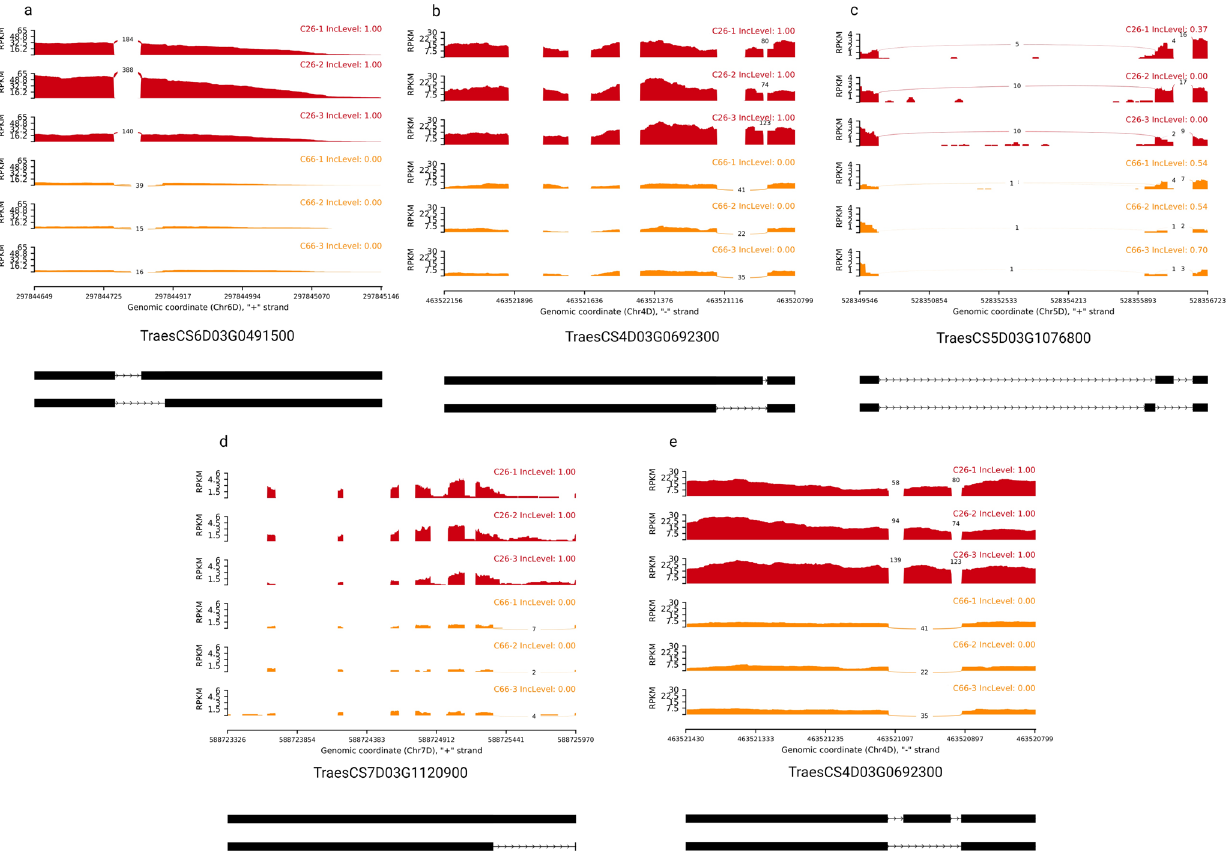
Fig. 9 Sashimi plots representing examples of the fi ve types of alternative splicing events in the shoot tissue of Ae. tauschii C26 line (diploid parent) vs SHW line C66. ( a ) Alternative 3 ′ splicing site; ( b ) Alternative 5 ’ splicing site; ( c ) Mutually exclusive exons; ( d ) Retained intron; ( e ) Skipped exon. The red plots represent the Ae. tauschii C26 parent transcripts and the yellow plots represent the SHW line C66 transcripts.